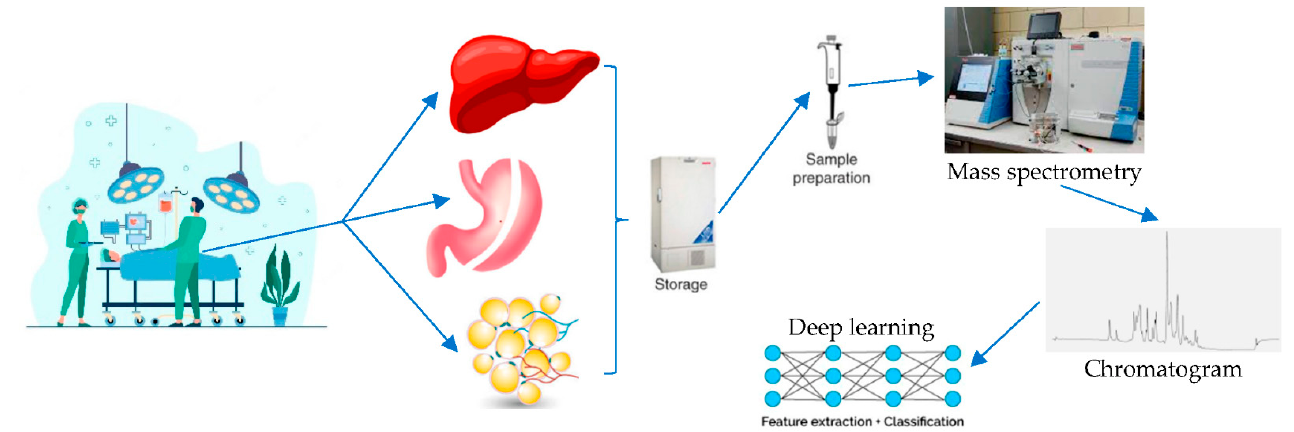
Figure 1. A schematic model of how tissue retrieved during bariatric metabolic surgery can be used for metabolomic analysis, and consequently, the resulting data undergo feature extraction and classification with deep learning techniques. As a first step, metabolomics analyses on tissue samples could be compared against metabolomic analyses on body fluids before operation (serum, urine, feces). At a following stage, fluctuations in metabolite concentrations in body fluids could be measured at standardized intervals after the bariatric operation and compared to both preoperative body fluid values, as well as tissue sample values. At a final stage, changes in metabolite concentrations could be correlated with clinical data that are routinely collected before and after bariatric surgery, such as BMI, blood glucose, HbA1c, HDL, LDL, total cholesterol, and triglycerides, etc.